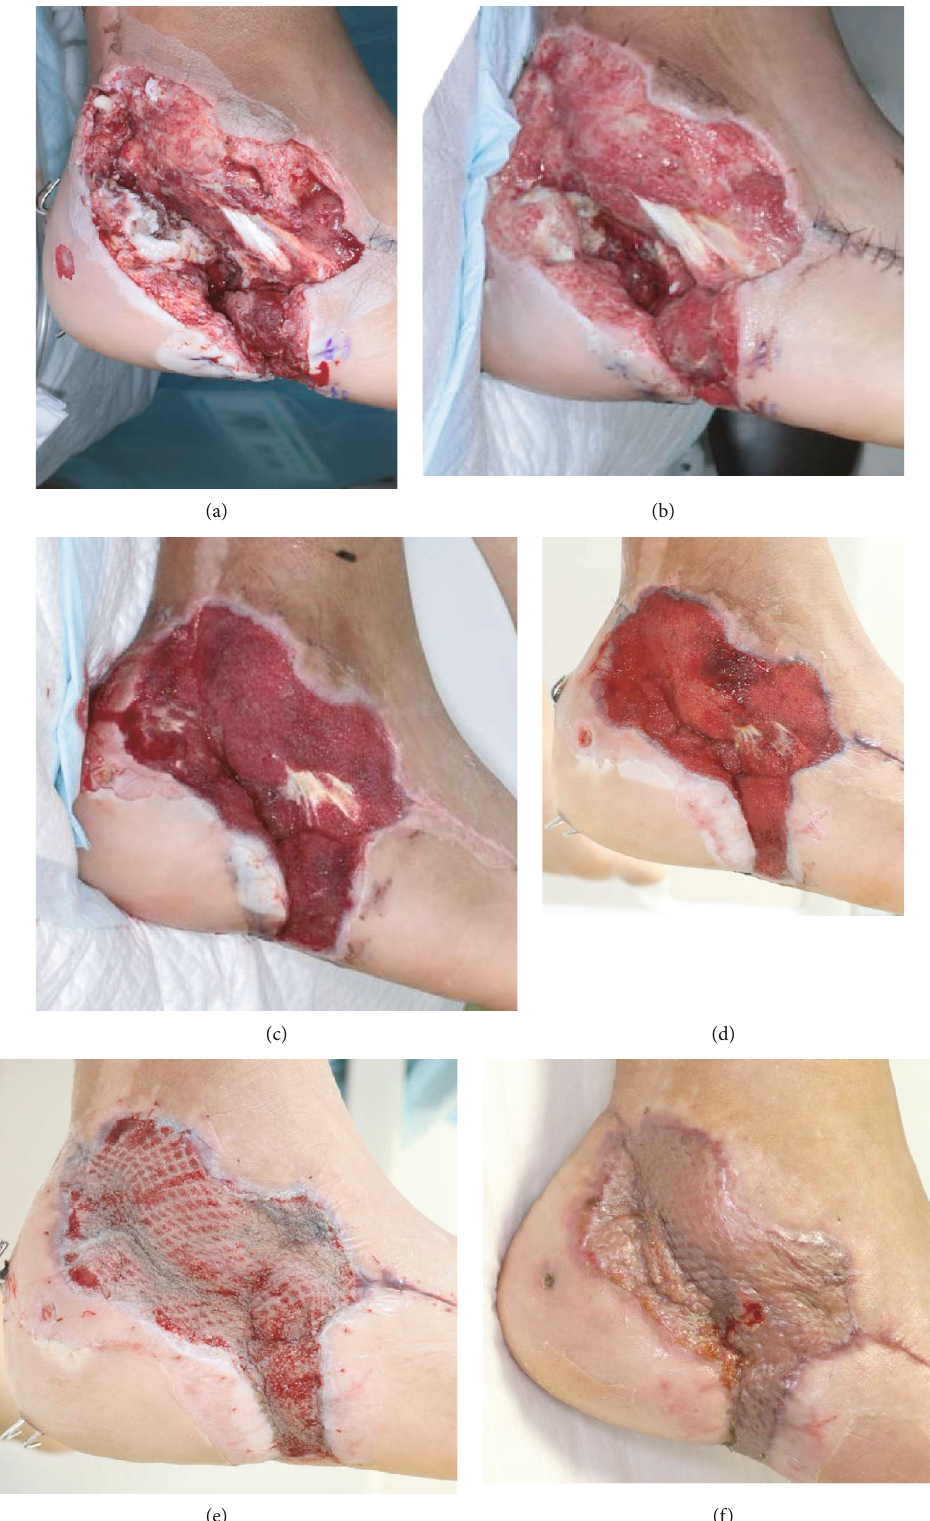
Figure 5: (a) At postinjury day (PID) 6, pus was still pooled in the wound. (b) PID-14 — signs of infection persisted, and continuous local antibiotic perfusion (CLAP) therapy was initiated. (c) PID-19 (5 days after initiation of CLAP therapy) — the signs of infection disappeared, and a well-vascularized granulation tissue growth was observed. (d) PID-36 — wound bed preparation was almost complete. (e) PID-47 (6 days after split-thickness skin grafting). (f) PID-64 — the infected wound was completely